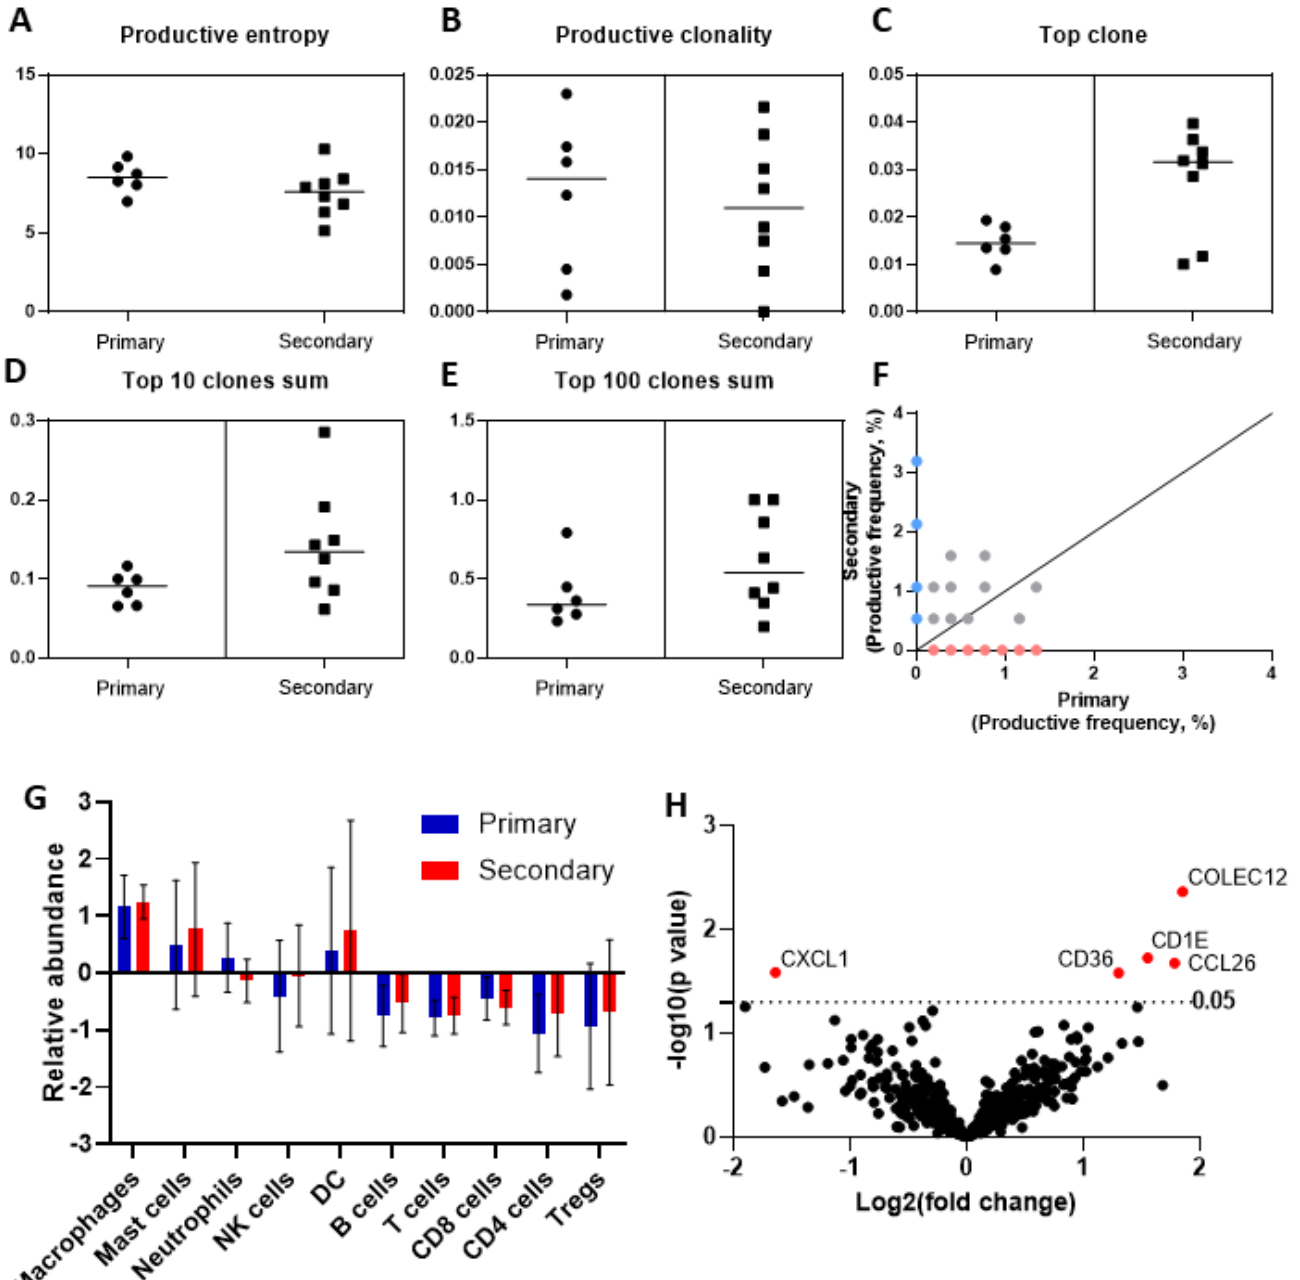
Figure 2. Evaluation of T-cell clonality and transcriptomic heterogeneity in primary and secondary HCC. Measures of T-cell clonality evaluated on the basis of deep sequencing of the T-cell receptor beta chain, using the ImmunoSEQ platform ( A – E ). Representative plot illustrating the differences in T-cell clonality, as measured by productive frequency in a representative pair of matched primary and secondary HCC samples ( F ). Targeted transcriptomic profiling, using the NanoString PanCancer Immune profiling panel, highlights homogeneity in the transcriptional signatures reflective of diverse immune cell types across primary and secondary samples ( G ). Volcano plot, illustrating the differentially regulated genes across primary and secondary HCC ( H ).